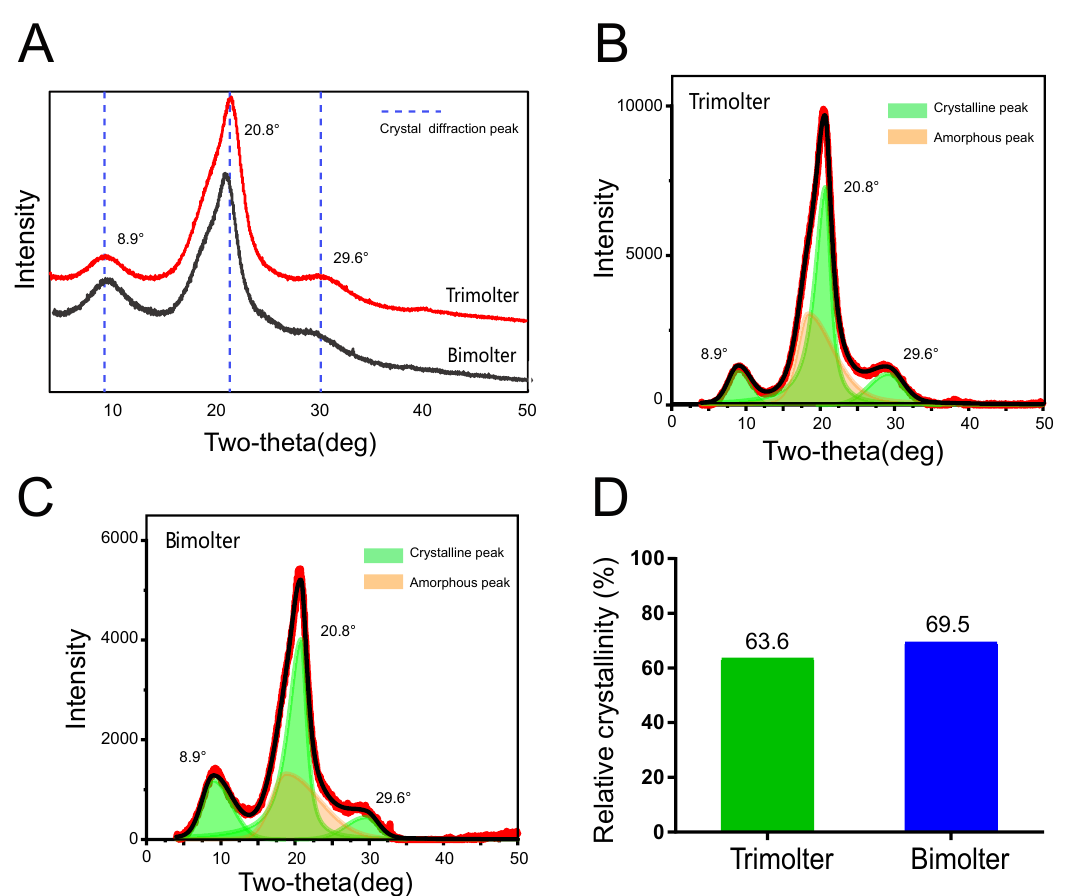
Figure 7. ( A ) X-ray di ff raction di ff ractograms of trimolter and bimolter silk. ( B ) Deconvolution of the trimolter silk di ff ractogram. ( C ) Deconvolution of the bimolter silk di ff ractogram. The peaks are fitted as the sum of five Gaussians: Three crystalline peaks (light green) and one amorphous halos (pale orange). The three crystalline peaks are indexed as 8.9 ◦ , 20.8 and 29.6 ◦ . ( D ) Relative crystallinity of trimolter and bimolter